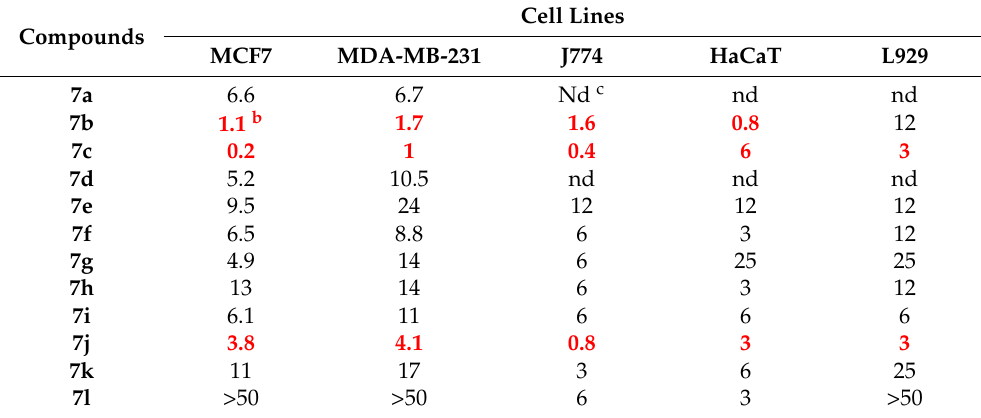
Table 1. Antiproliferative activity of compounds 7a – l , IC 50 a , µ